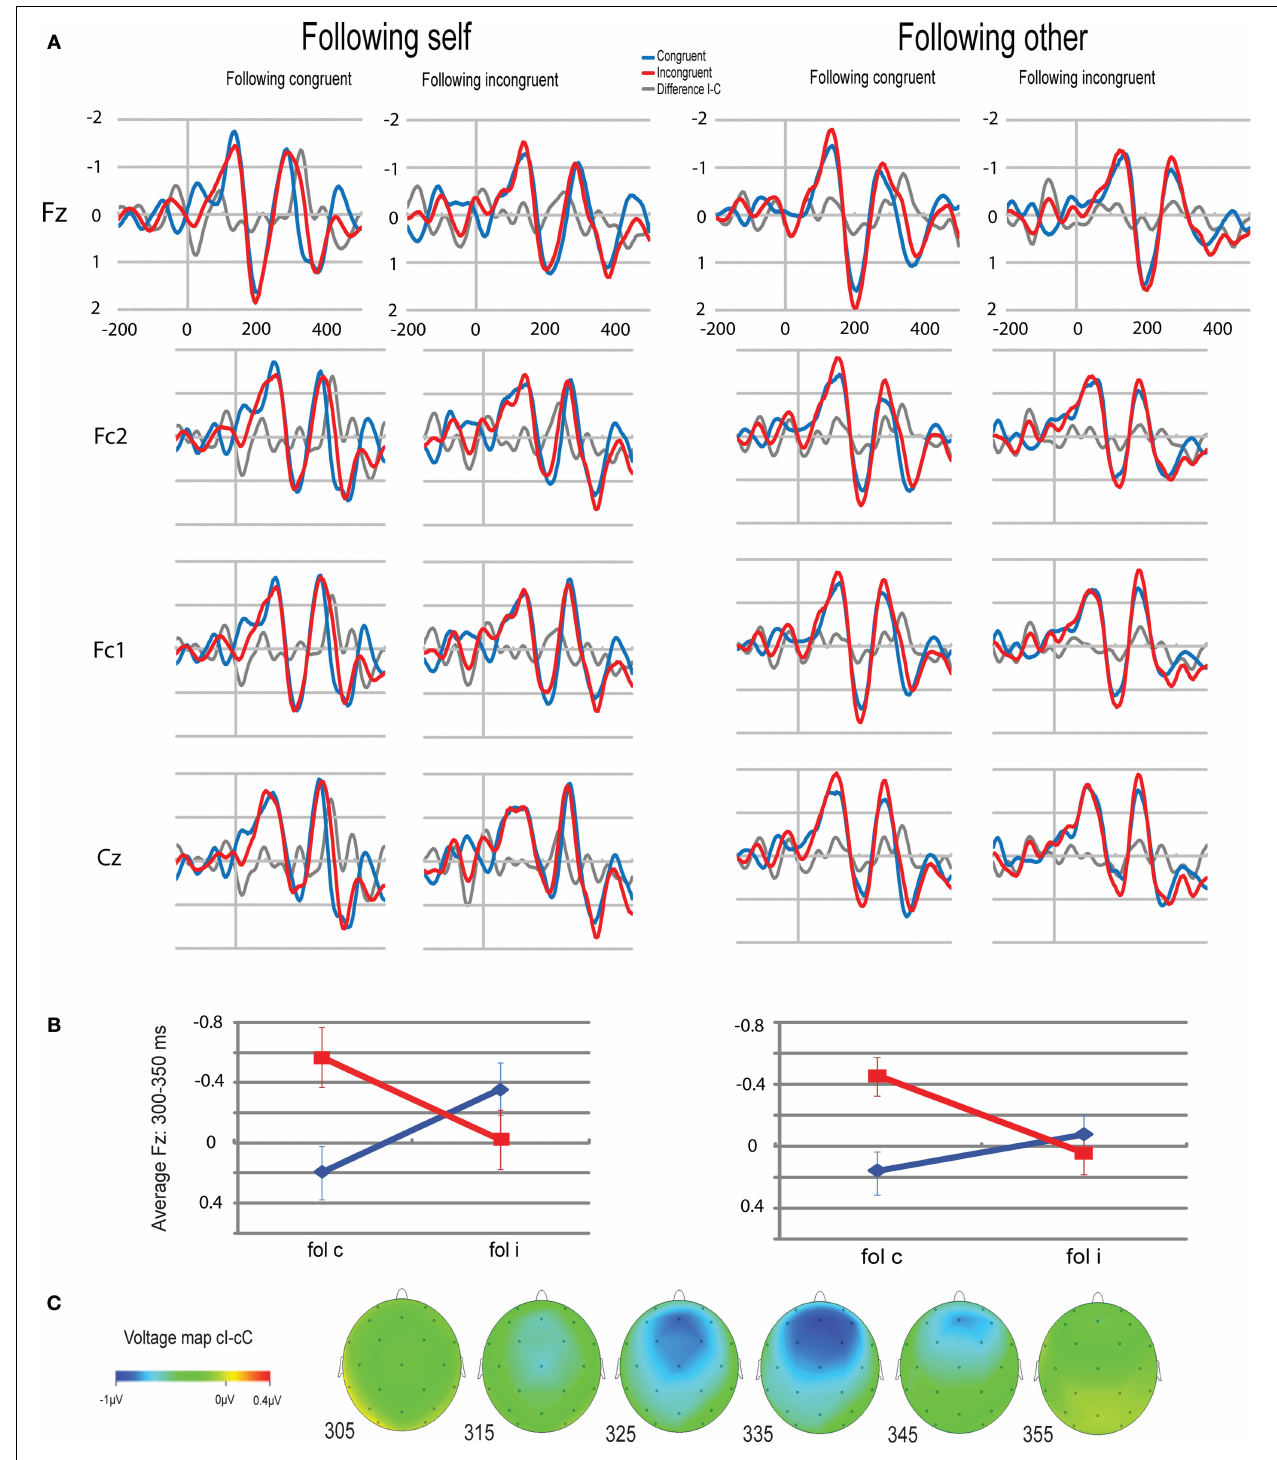
amplitude of Fz, split for following self and following other trials. The average EEG amplitude is plotted as a function of congruency of the previous trial ( x -axis) and congruency of the currents trial (lines). Bars represent the standard error of the mean, computed over the amplitude, as normalized per subject. (C) Voltage map of the difference wave of cC and cI trials. Note the frontocentral scalp distribution of the